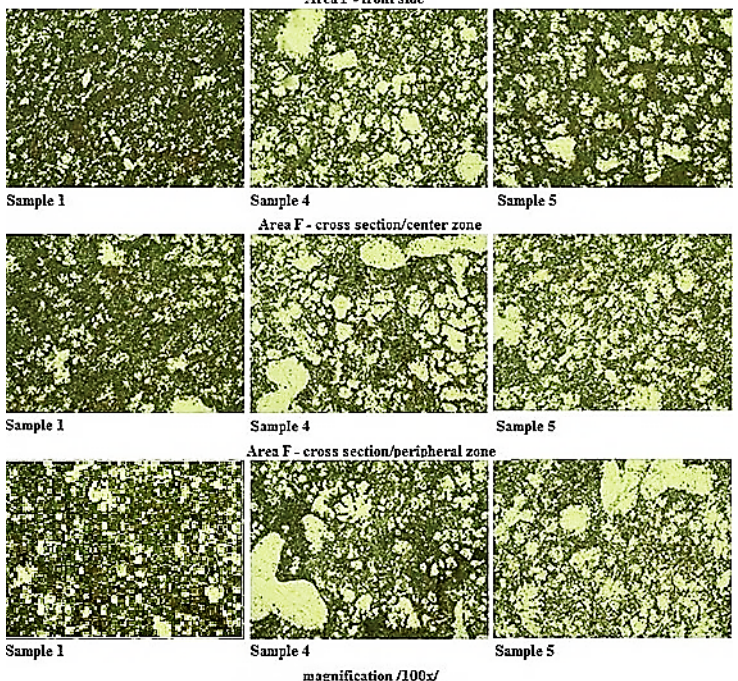
Figure 5. Structure in the location of the scratch pattern of samples taken from the F Area.